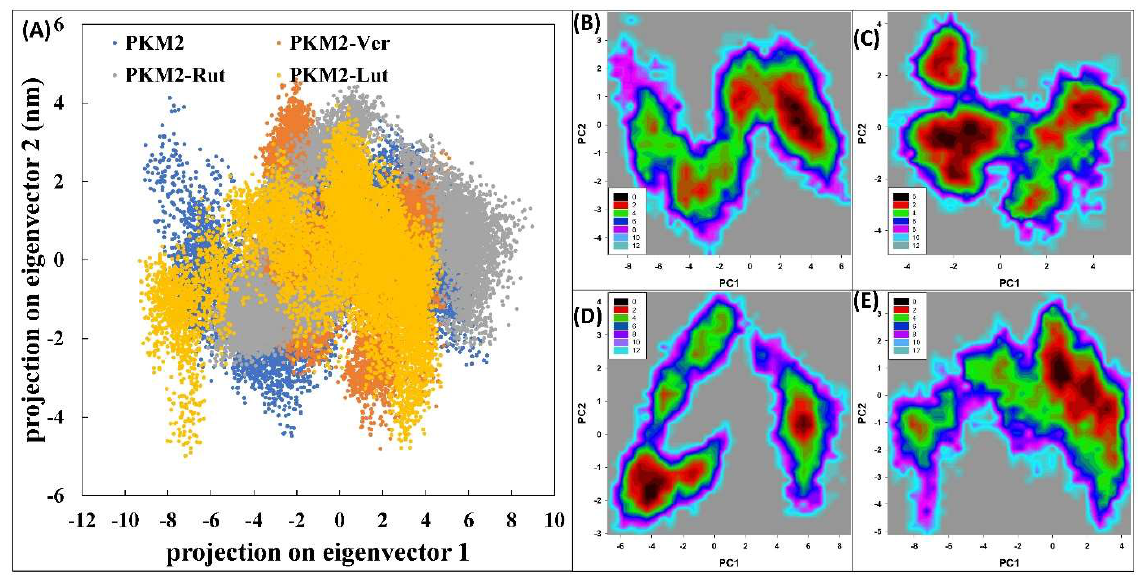
Figure 7. ( A ) Principal component analysis (PCA) of PKM2 in the absence and presence of Ver, Rut, and Lut. ( B ) Free energy landscape plot of PKM2 alone. ( C ) Free energy landscape plot of PKM2-Lut complex. ( D ) Free energy landscape plot of PKM2-Rut complex. ( E ) Free energy landscape plot of PKM2-Ver complex.